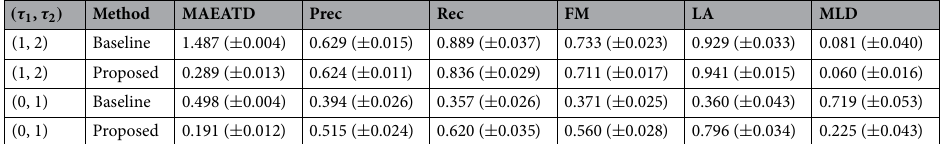
Table 1. Estimation performance of the baseline method and our proposed method using warping-based cost averaged over 100 datasets. We used Gaussian kernel with a bandwidth with the best β